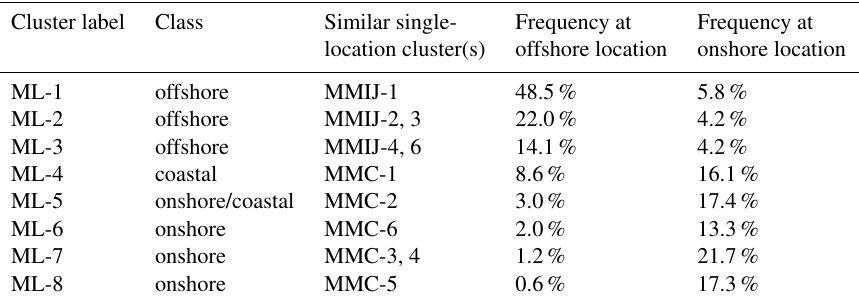
Table 3. Classification of the multiple-location clusters and frequencies of occurrence of the clusters at the on- and offshore reference locations (met masts Cabauw and IJmuiden). Cluster